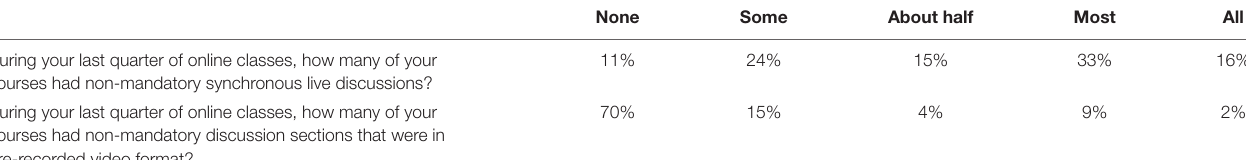
TABLE 4 | Distribution of survey responses to questions about non-mandatory discussion